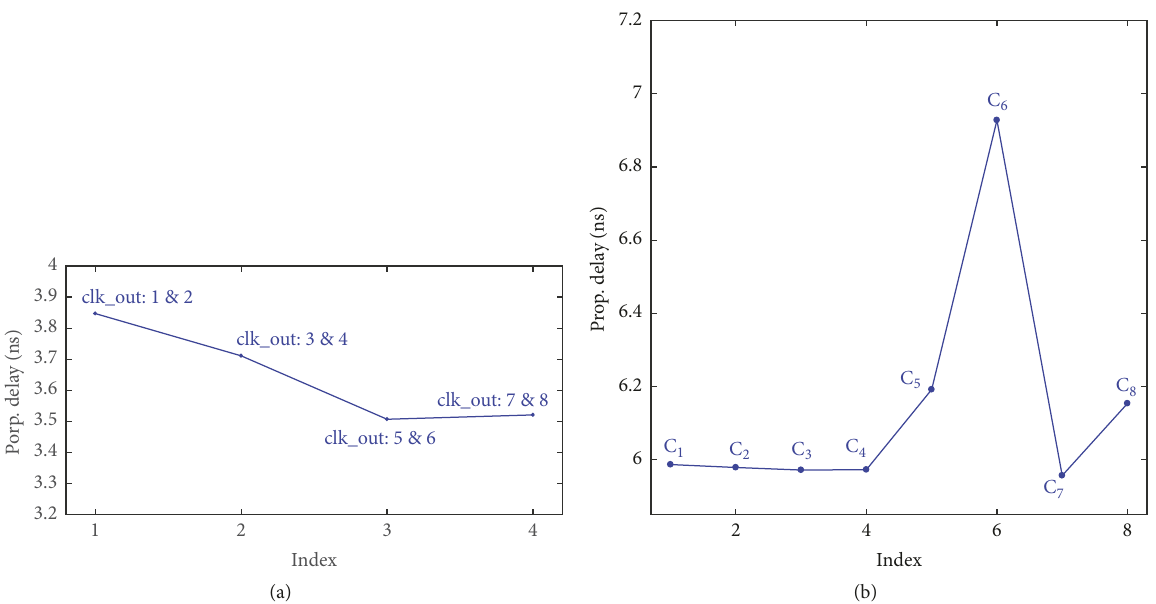
Figure 4: Simulated propagation delay of signals based on timing analysis. (a) Propagation delay of 8 RF board clock signals at 38.4 MHz and (b) Propagation delay of 8 orthogonal